Question: What direction does the quantity move in — increasing or decreasing?
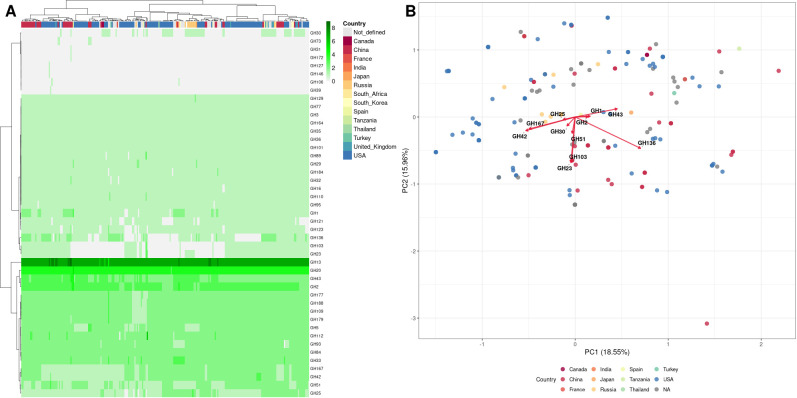
Answer: increasing